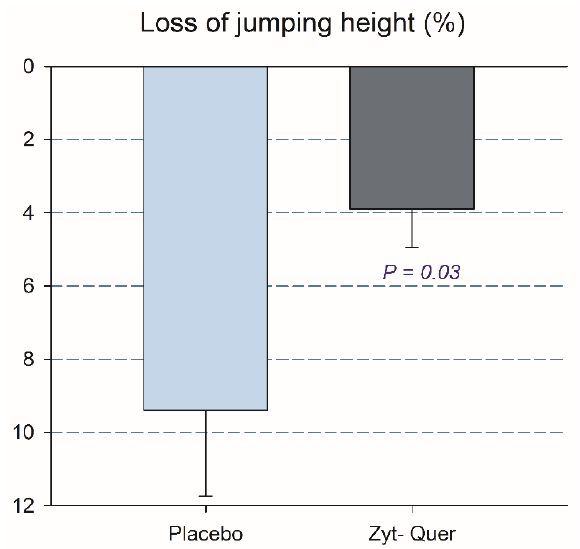
Figure 2. Jumping height loss 24 h after the 10 km race followed by 100 drop jumps. The error bars represent the standard error of the mean. Placebo, N = 23; polyphenols, N = 25.